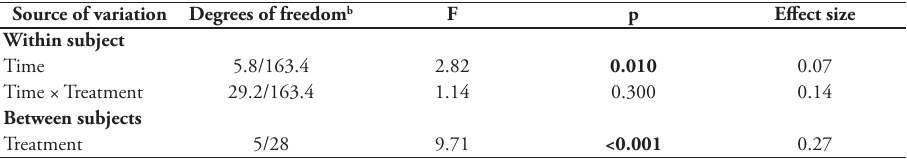
Table 3. Summary of results of mixed ANOVA assessing the influence of time and treatments on reac- tion time. a